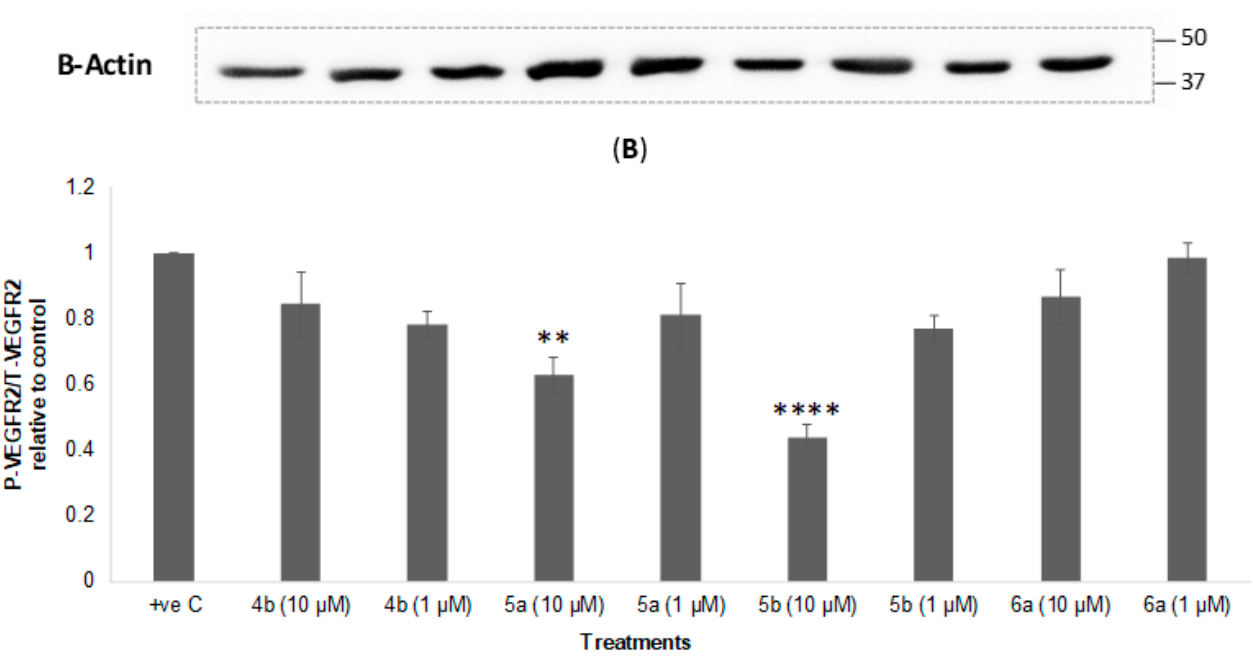
Figure 4. VEGFR2 induced phosphorylation inhibition activity of flavonoid derivatives ( 4b , 5a , b and 6a ) on HUVEC cell lysates. ( A ) Representative Western blot images of the HUVECs proteins; T- VEGFR2, P-VEGFR2 and β -Actin. Images were analysed using ImageJ software; ( B ) VEGFR2-induced phosphorylation inhibition expressed as a ratio to the +ve control (10 ng/mL VEGF-enriched media). Data are expressed as mean ± standard error of the mean (SEM), n = 3. Statistical significance was estimated with respect to the +ve control by one-way ANOVA, followed by Dunnett’s multiple comparison test (** p < 0.01, **** p < 0.0001).